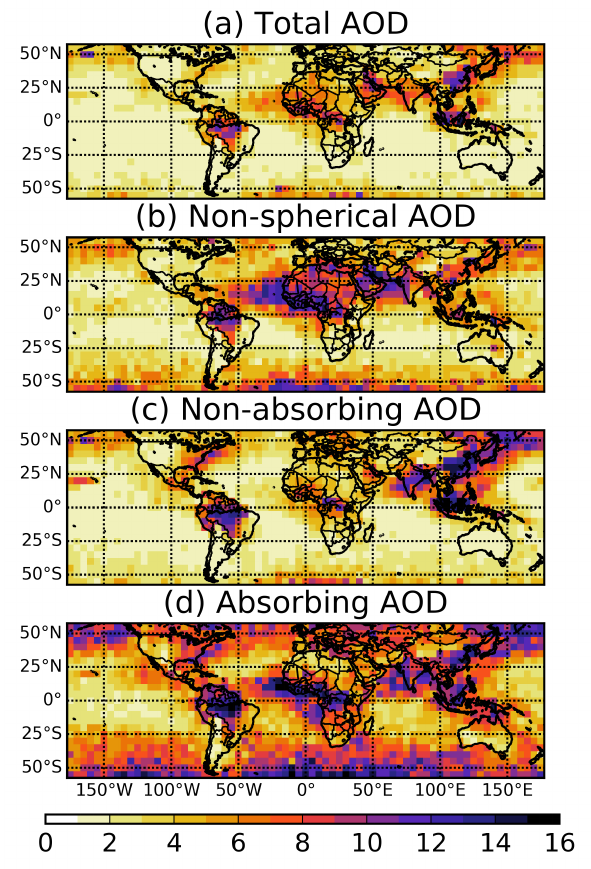
Figure 3. The minimum record lengths required to obtain stable annual mean climatology of ( a ) total, ( b ) non-spherical, ( c ) non-absorbing, and ( d ) absorbing aerosol optical depths within the predefined accuracy levels ± 0.01 AOD for ( a ), ± 0.004 for ( b ), and ± 0.005 for ( c ) and ( d